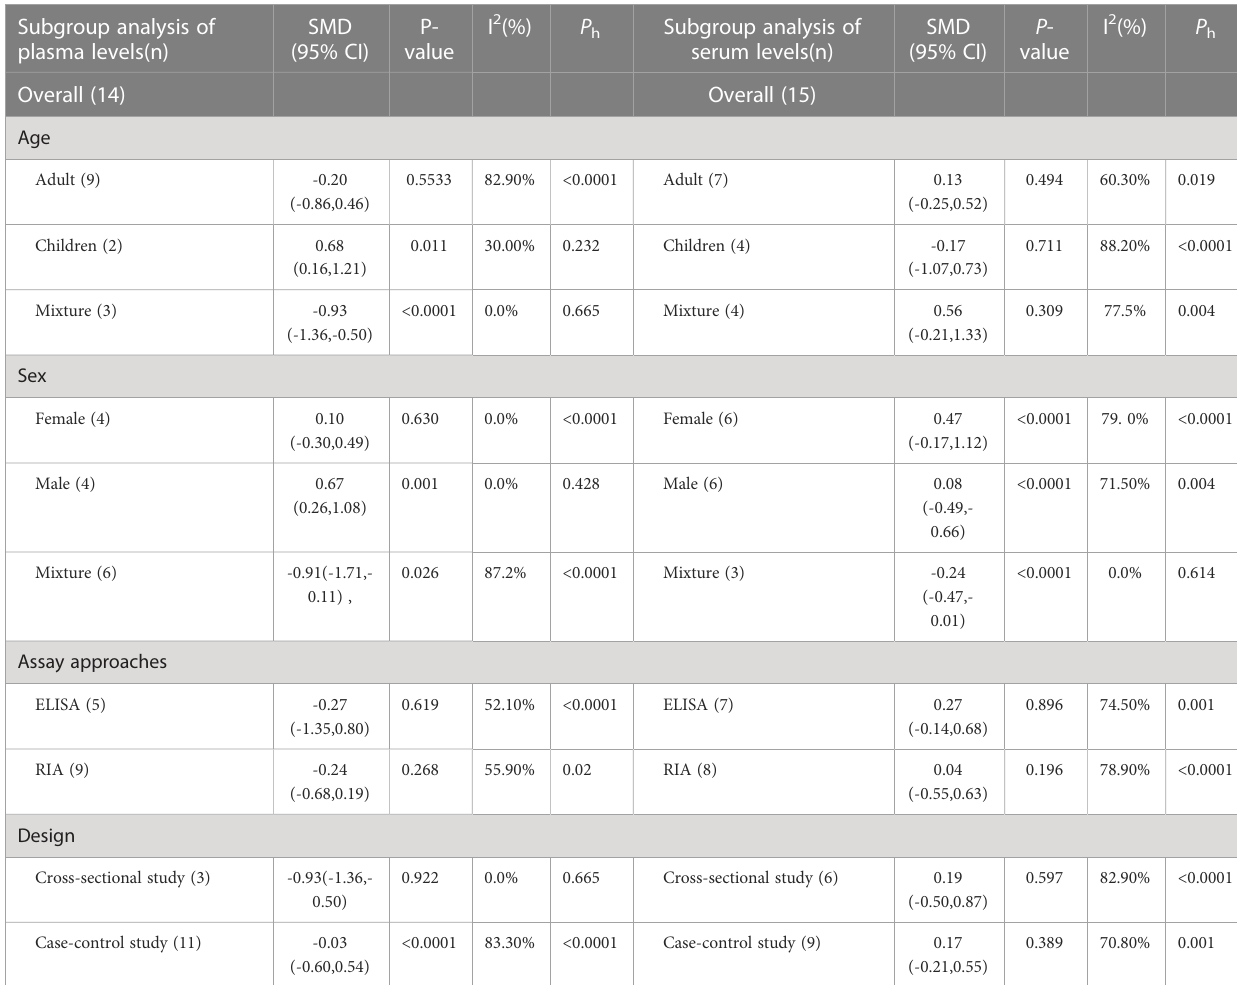
TABLE 3 Subgroup analyses of leptin concentrations in CF and